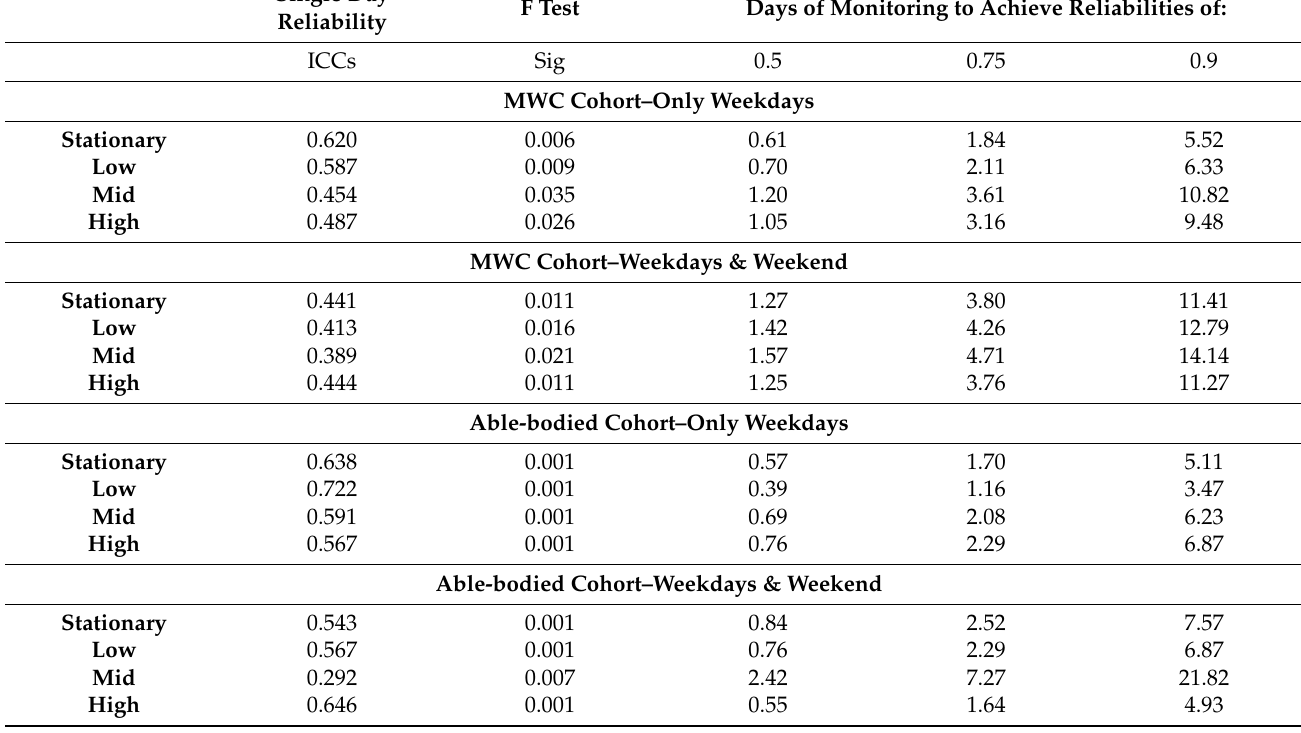
Table 4. Intraclass reliability coefficients (ICCs) for MWC and able-bodied cohorts based on only weekday measurements (3 days) and weekday & weekend (3 weekdays, 1 weekend) measurements and the number of required days of monitoring to obtain moderate, good, and excellent